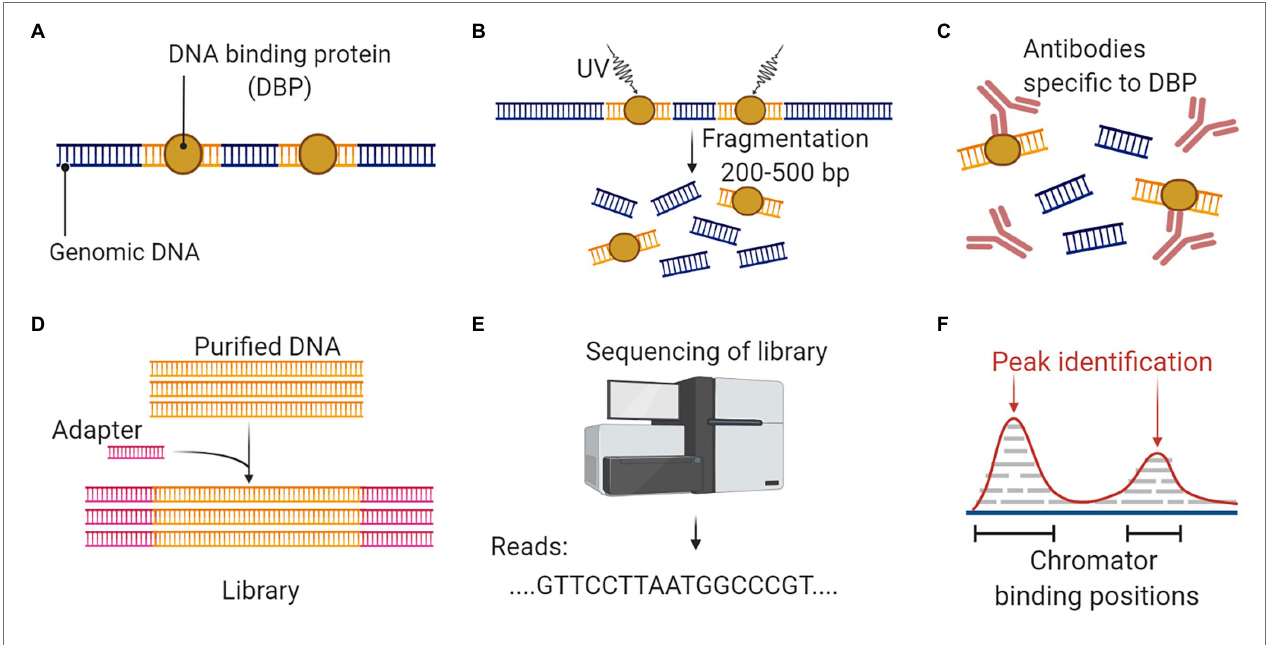
FIGURE 7 | An overall workflow for ChIP Seq to analyze protein interactions with DNA. (A) Isolation of genomic DNA with conserved binding proteins. (B) Crosslinking and DNA fragmentation to access the DNA-protein complex. (C) Immunoprecipitation with protein-specific antibodies to separate the DNA-protein complex. (D) DNA purification is followed by adaptor ligation to prepare the sequencing library. (E) Discovery of DNA biding segments using next-generation sequencing platform. (F) Data analysis and alignment to reference genome will identify targeted DNA sequences that interact with the protein. This figure is adapted from “ChIP sequencing,” by BioRender.com (2022). Retrieved from